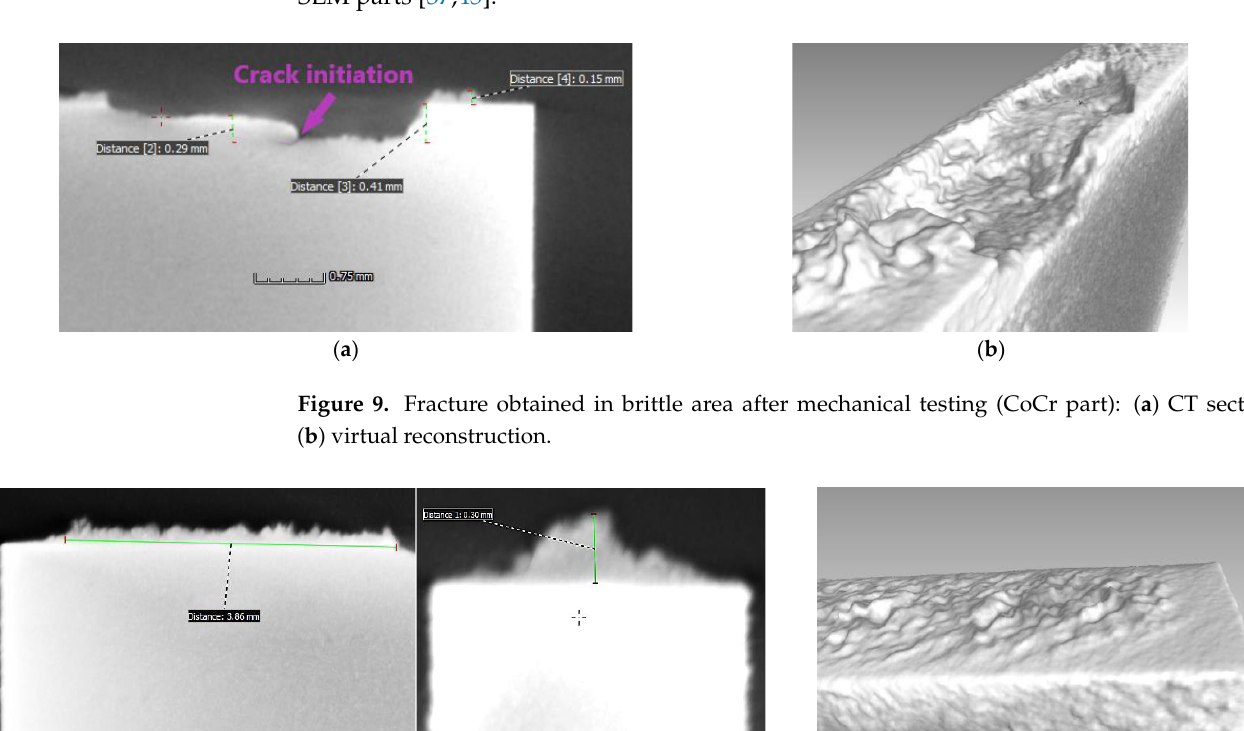
Figure 8. ( a ) Representative image of surface quality archived by laser melting of CoCr powder